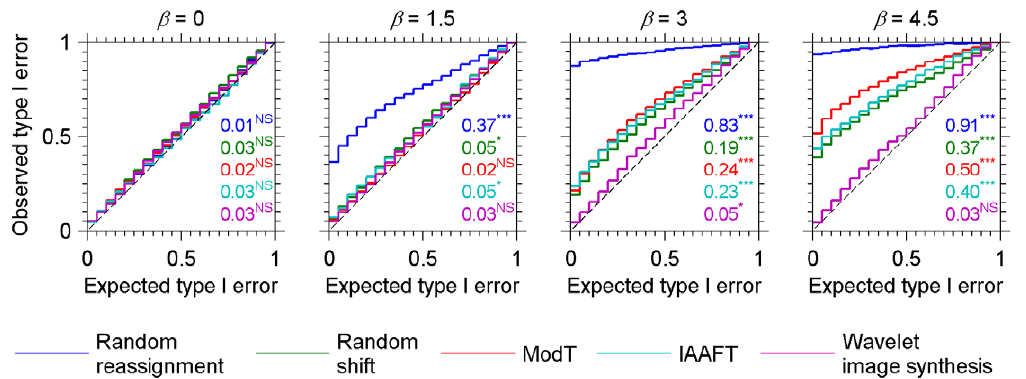
Figure 2. Type I error calibration curves for continuous fractal patterns generated through Fourier synthesis of 32 6 32 pixels images [ 27 ] (see Fig. 1 for examples). Observed versus expected type I error probabilities resulting from independence tests on 1000 pairs of simulated images, are plotted for every combination of method (colour curves) and degree of spatial autocorrelation (panels) as measured by the energy spectrum exponent, b . Methods compared are random reassignments, random shifts, corrected t -test of Dutilleul (ModT), iterative amplitude adjusted Fourier transform (IAAFT), and wavelet-based image synthesis. Each bin is 0.05 wide. The Kolmogorov-Smirnov (K.-S.) maximum difference statistic which measures the departure from the line of identity (dashed line) is indicated for each curve along with results of the derived test of the departure: ***= p -value , 0.001; *=0.01 # p -value , 0.05; NS=not significant.